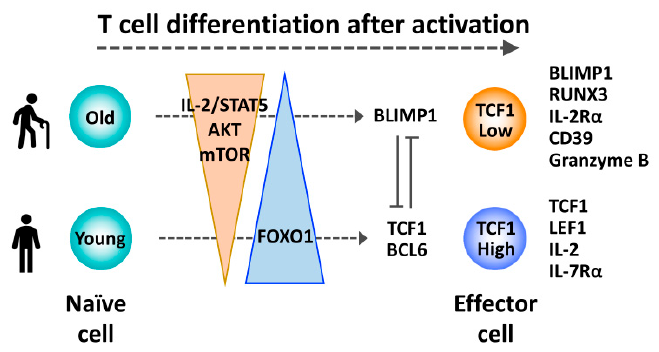
Figure 3. Reduced TCF1 expression promoting a differentiation bias of activated aged T cells toward terminal effector cells. After priming, increased IL-2/STAT5 signaling and sustained activation of the AKT-mTOR pathway favors differentiation of aged T cells into TCF1 low terminal effector cells, due to reduced FOXO1/TCF1 expression and increased BLIMP1 expression.